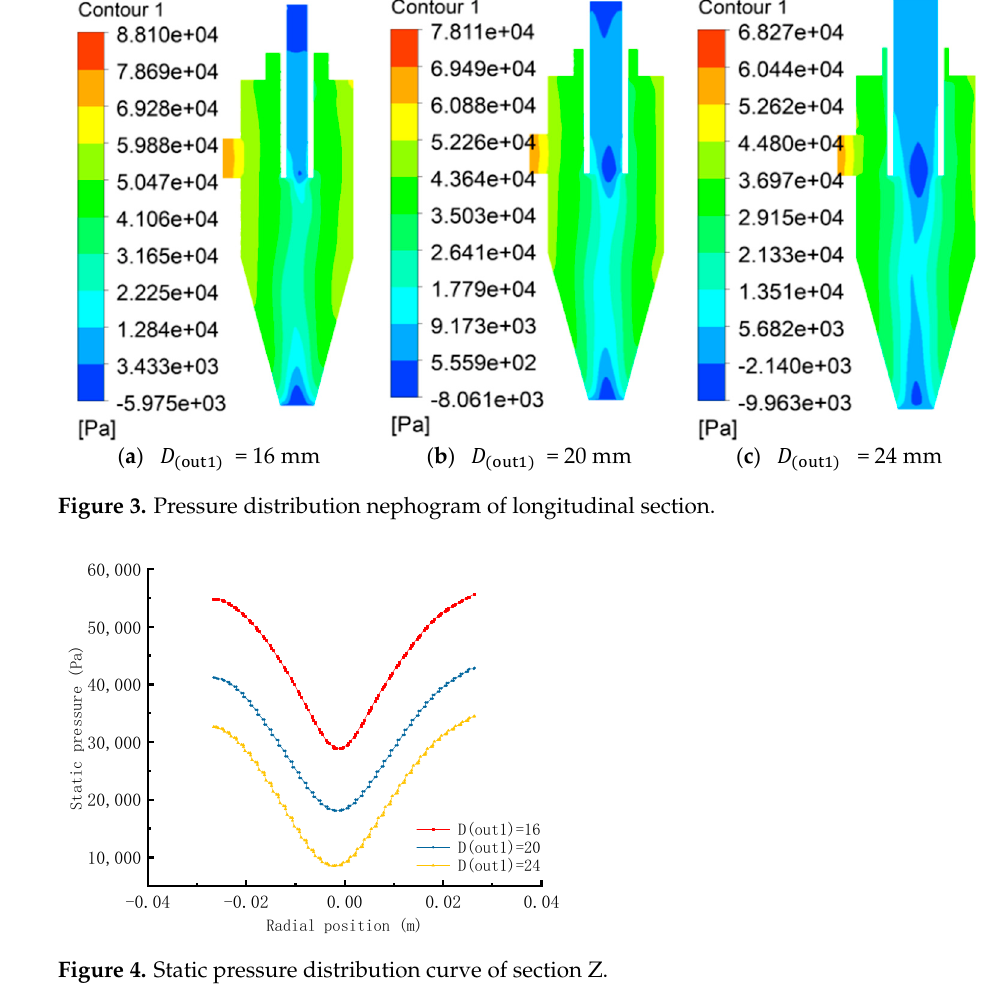
( c ) Axial velocity distribution Figure 5. Section Z velocity distribution curve. It can be seen from Figure 6 that the velocity distribution shows a spirally decreasing state, and the velocity gradient was relatively uniform. It can be inferred that when 𝐷 ((cid:2925)(cid:2931)(cid:2930)(cid:2869)) = 24 mm, the trace was most concentrated at the bottom of the exhaust port, indicating the best bubble flow effect; when 𝐷 ((cid:2925)(cid:2931)(cid:2930)(cid:2869)) = 16 mm, the velocity concentrated at the bottom of the exhaust port was low, indicating that the bubble flow effect was poor. From the veloc- ity trace distribution of the bubble combined with the simulation analysis, it can be con- cluded that the gas discharge efficiency of 𝐷 ((cid:2925)(cid:2931)(cid:2930)(cid:2869)) = 24 mm is 8% higher than that of 𝐷 ((cid:2925)(cid:2931)(cid:2930)(cid:2869)) = 16 mm.